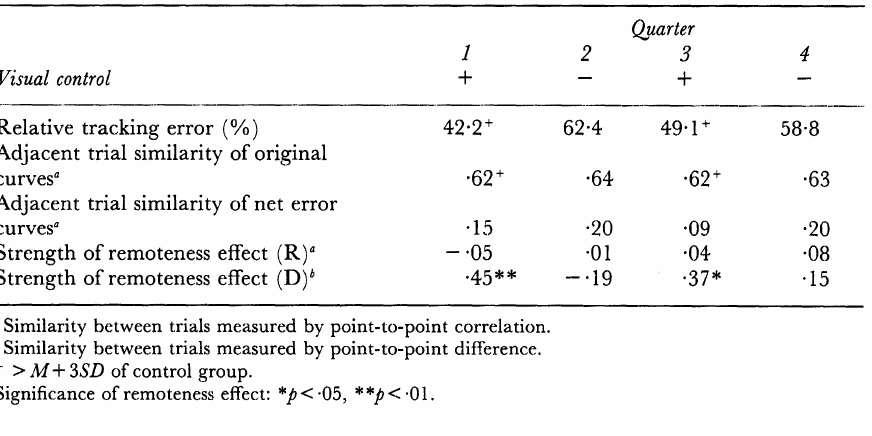
TABLE 4_ ~'jfect of intermittent withdrawal oj visual control on tracking in a deaJferented patient ( experiment